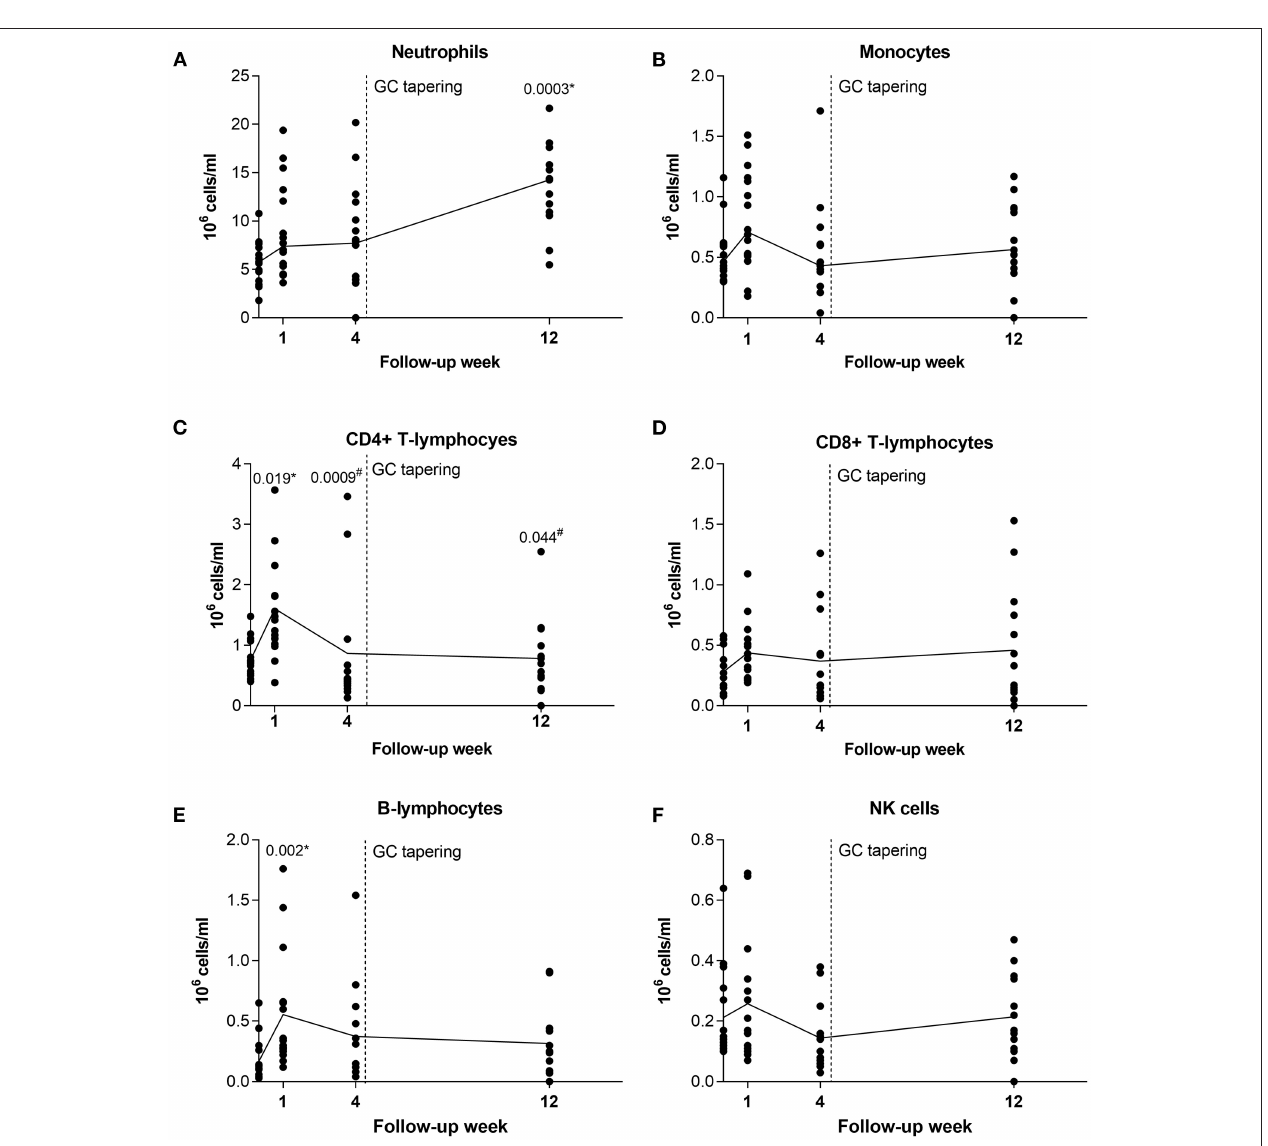
FIGURE 3 | Longitudinal analysis of leukocyte subsets in GCA patients before and during therapy with GC. After pre-treatment sampling, all patients received GC and therapy tapering started after week 4 (indicated with vertical dotted line). Shown are medians from each follow-up time point (black horizontal connecting line) for (A) neutrophils; (B) monocytes; (C) CD4 + T-lymphocytes; (D) CD8 + T-lymphocytes; (E) B-lymphocytes; and (F) NK cells. GC, glucocorticoids; GCA, giant cell arteritis; NK, natural killer. * indicates statistical significance between the corresponding timepoint and T 0 ; # indicates statistical significance between the corresponding timepoint and week